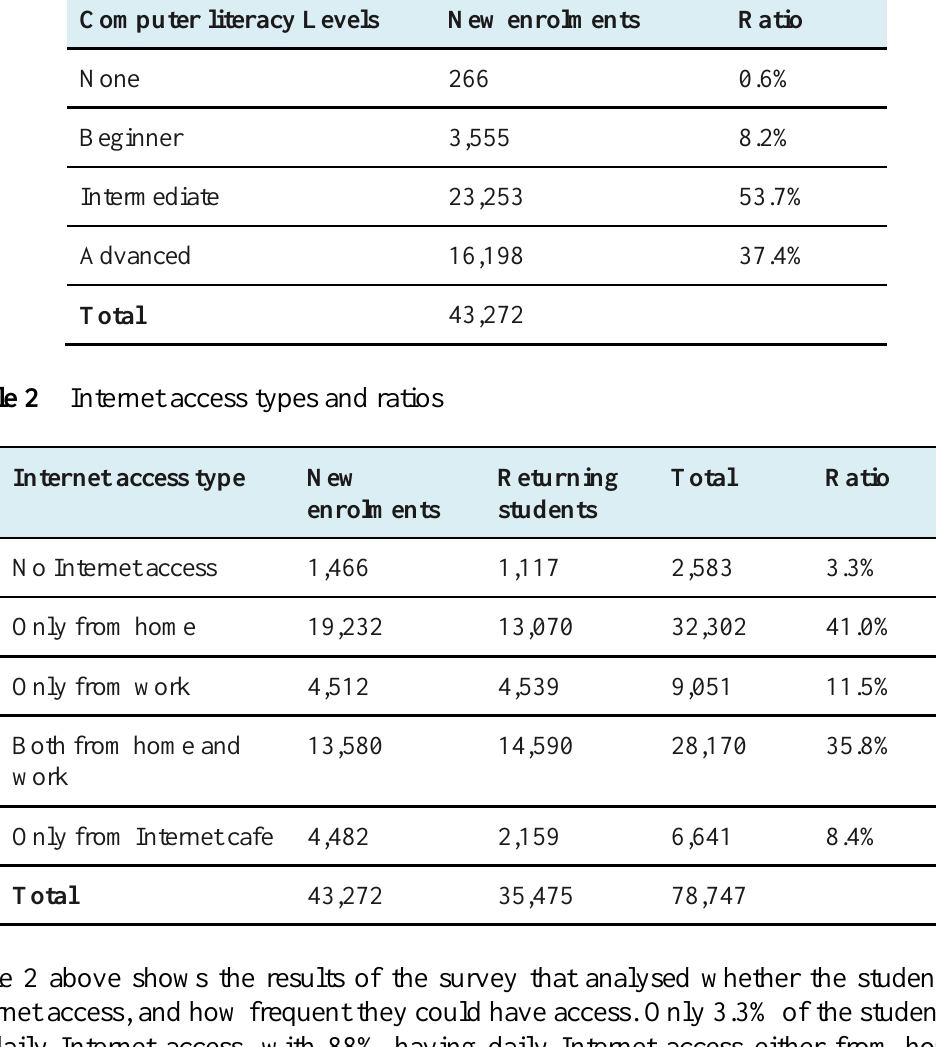
Computer literacy levels Computer literacy Levels